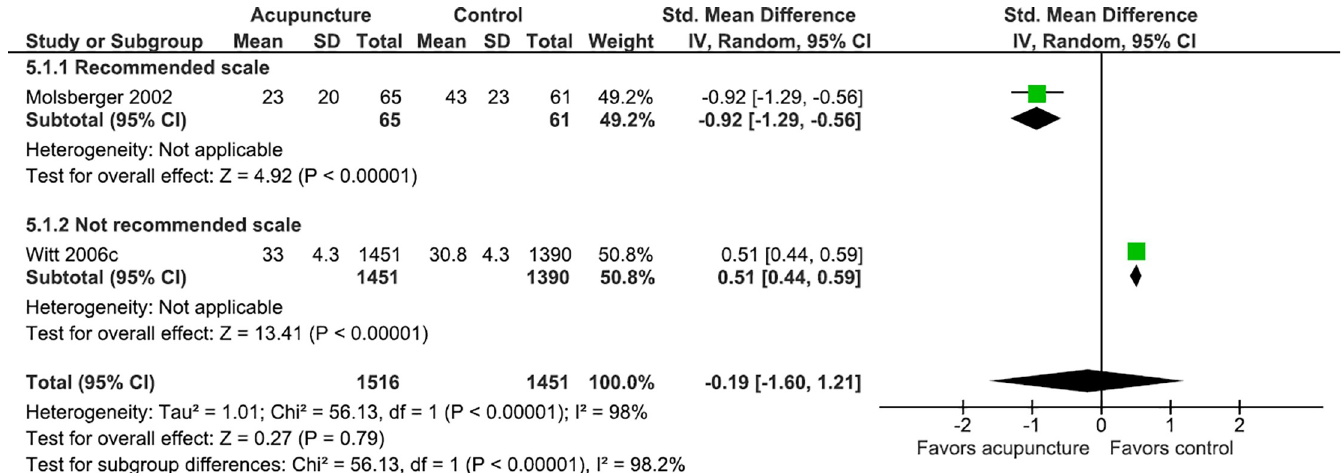
Fig 7. Meta-analysis of the effect of acupuncture in patients with neck pain stratified by the use of recommended scales or not.